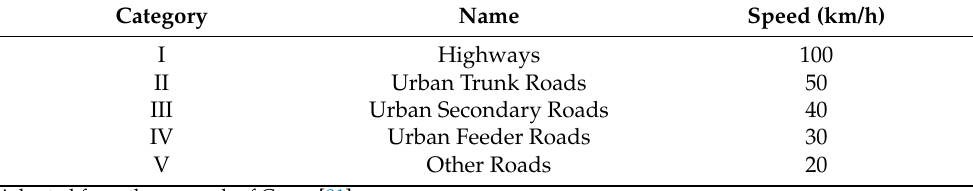
Table 2. Road classification and speed assignment